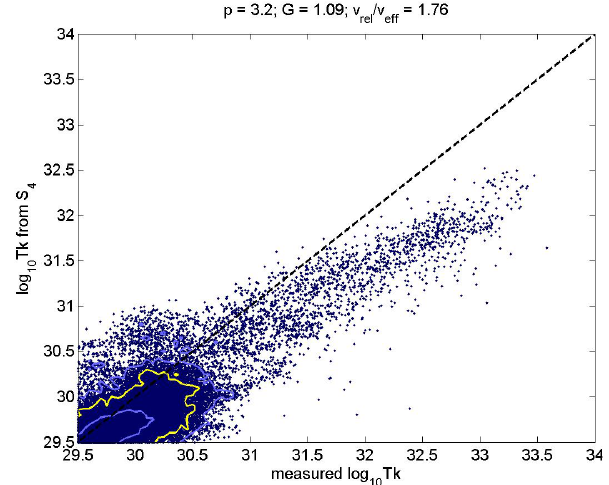
Fig. 11. log 10 T k estimated from S 4 compared to the measured val- ues, using p =3.2, G =1.09 and v rel /v eff